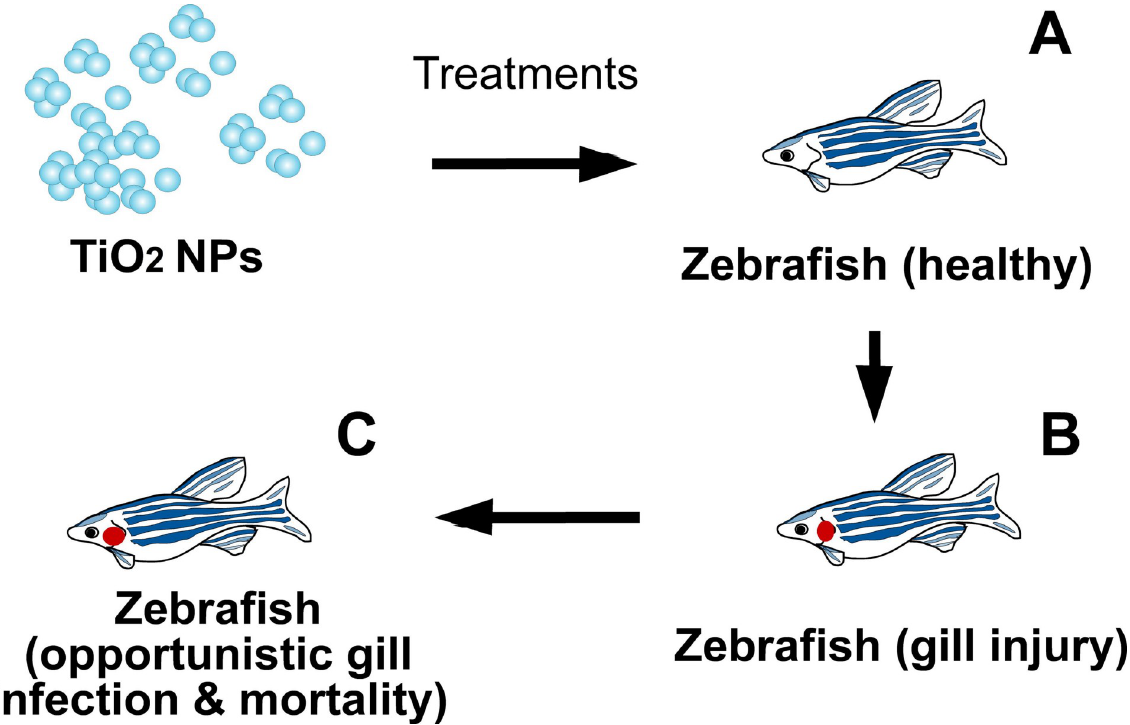
Fig 5. A model for putative role of opportunistic gill infection in TiO 2 NP-induced mortality in zebrafish. After TiO 2 NP treatments, the gill of healthy zebrafishes (A) become injured (B). The gill injury further leads to opportunistic infection and increased mortality in zebrafish (C).